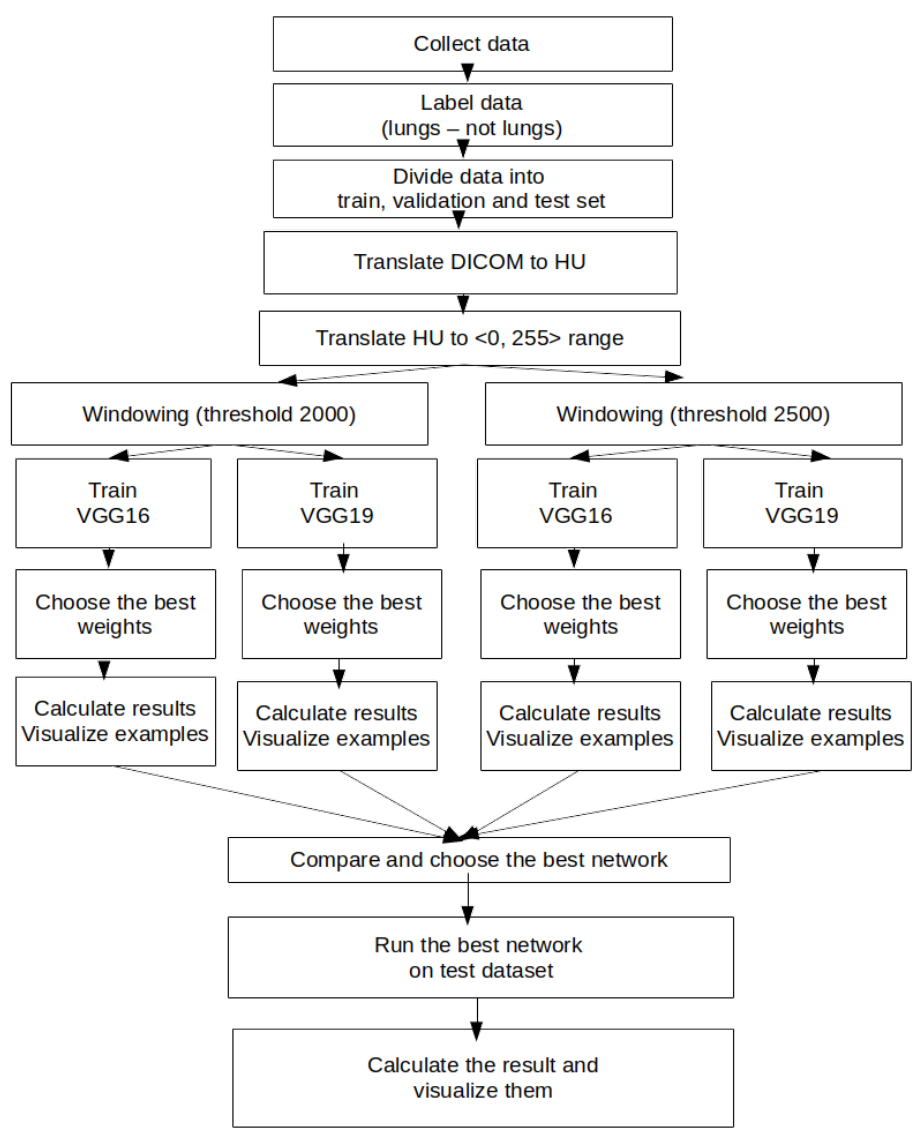
Figure 3. CNN selection procedure. HU, Hounsfield unit. Table 2. Number of CT slices used as the input data for the